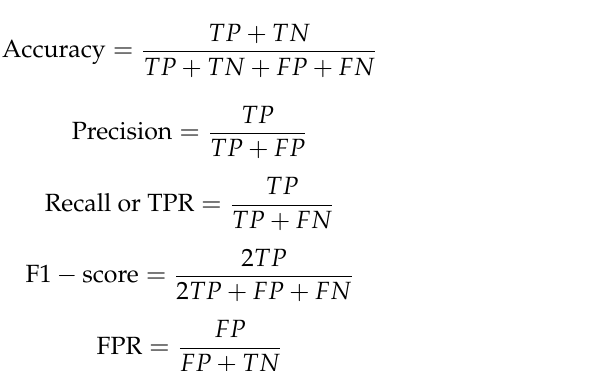
Table 3. Comparative analysis between existing and proposed mechanisms using the CSE-CIC-IDS 2018 dataset.